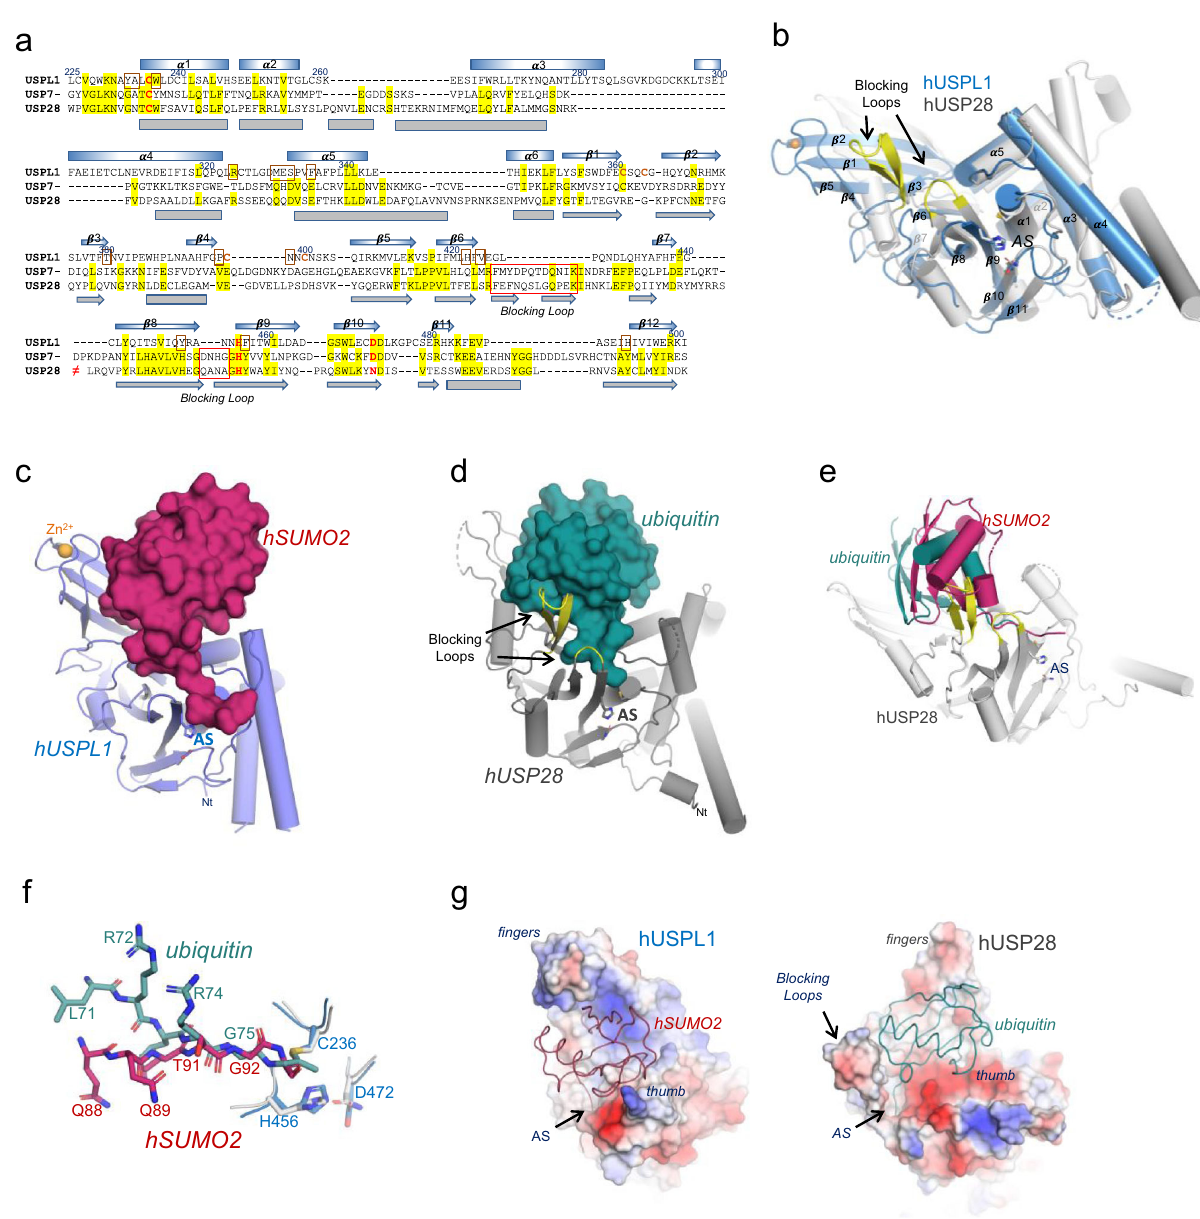
Fig. 3 Comparative analysis of USPL1 with the ubiquitin USP28. a Alignment of sequences corresponding to the catalytic domains for human USPL1, USP7, and USP28 based on the structural alignment of human USP7 (PDB code 4WPI) and USP28 (PDB code 6HEJ) 35,44 . Secondary structure elements are numbered ( β -strands and α -helices) and indicated above the alignment for USPL1 (blue) and below the alignment for USP28 (gray). Gaps are denoted by --- and the large sequence insertion within USP28 is depicted ≠ to indicate that the sequence is missing from the alignment. Side chain identity (100% conservation) is denoted in the alignment by a yellow background. Three catalytic residues are depicted in red. Active site-blocking loops are denoted by red squares. All images were prepared with PyMOL 45 . b Cartoon representation of the structural overlapping of the catalytic domains of USPL1 with USP28 (PDB code 6HEK) 35 . The blocking loops connect β -strand 6 and β -strand 7, and β -strand 8 and β -strand 9 of the palm domain are missing in USPL1 and shown in yellow. Active site residues (AS) are shown in stick representation. Zinc atom is shown in yellow. c Surface representation of SUMO2 (red) in complex with USPL1, shown in cartoon representation (blue). Active site residues (AS) are shown in stick representation. Zinc atom is shown in yellow. d Surface representation of ubiquitin (dark green) in complex with USP28 (PDB code 6HEK) 35 , shown in cartoon representation (gray). Active site residues (AS) are shown in stick representation. Zinc atom is shown in yellow. Blocking loops (yellow) are indicated. e Structural comparison of C-terminal tails of SUMO2 (red) and ubiquitin (green) in complex USPL1 and USP28, respectively. f Structural overlapping of SUMO2-USPL1 and ubiquitin-USP28 displaying the collision of the blocking loop (yellow) of USP28 (gray) with SUMO2 (red). g Electrostatic potential surface representation for USPL1-SUMO2 and USP28-ubiquitin to highlight the differences between USPL2 and USP28 in the analogous surface. SUMO2 (red) and ubiquitin (dark green) are shown in a line Such tyrosine, located one position after the active site histidine, both highly conserved in USPL1 (Fig. 4 and Supplementary is highly conserved in all ubiquitin-speci fi c USPs (Fig. 3 and Fig. 1). In ubiquitin the backbone oxygen of Leu73 (equivalent to Supplementary Fig. 1), but has been substituted by phenylalanine Gln90 in USPL1) forms a hydrogen bond with the side chain of a in all USPL1 orthologs, which forms hydrophobic contacts with tyrosine (replaced by Phe457 in USPL1) (Supplementary Fig. 4).